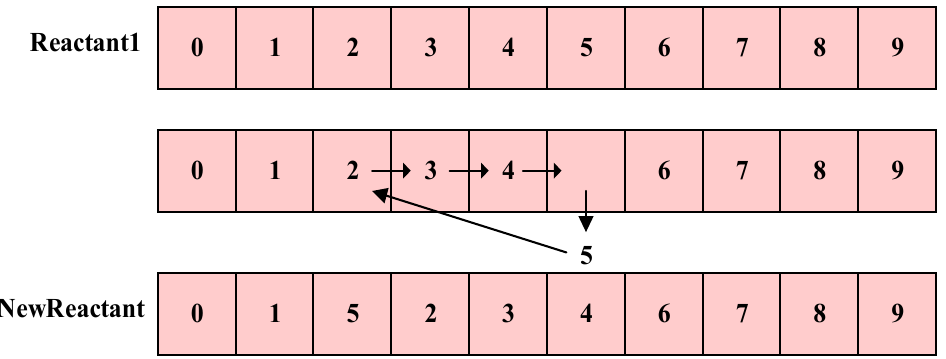
Figure 9. Displacement reaction operation representation.